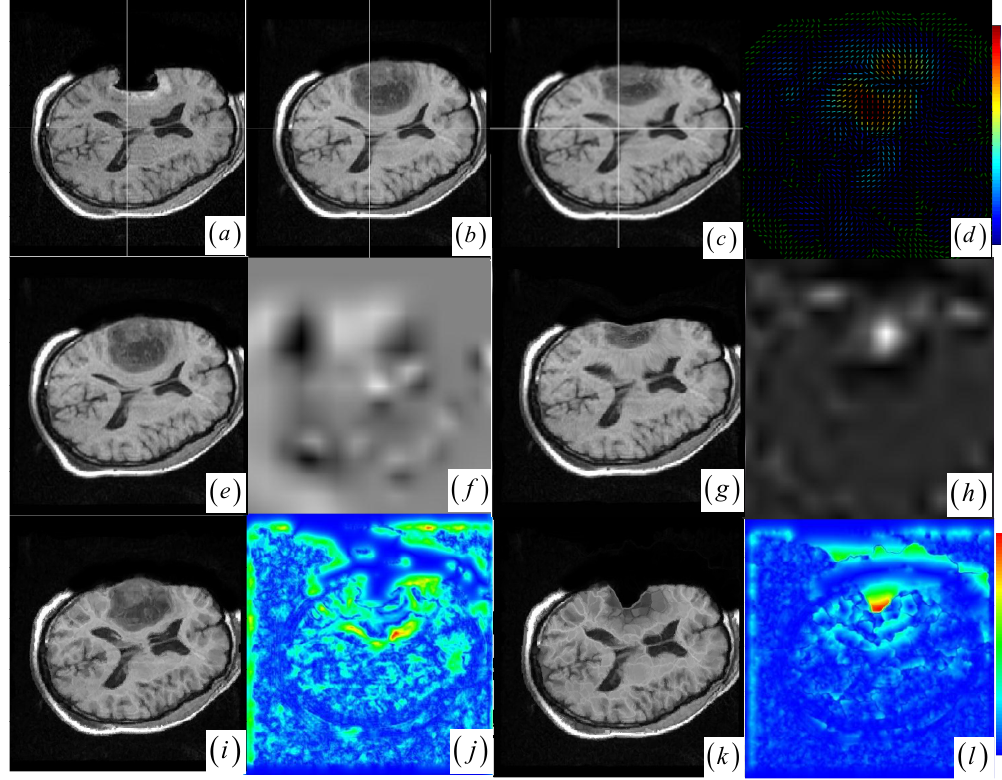
Figure 4. (a)–(b) Intra- and pre-operative MR images. (c) JKC. (d) Displacement vector field. (e) BMI. (f) BMI deformation image. (g) BCR. (h) BCR deformation image. (i) DEM. (j) DEM deformation image. (k) DIF. (l) DIF deformation